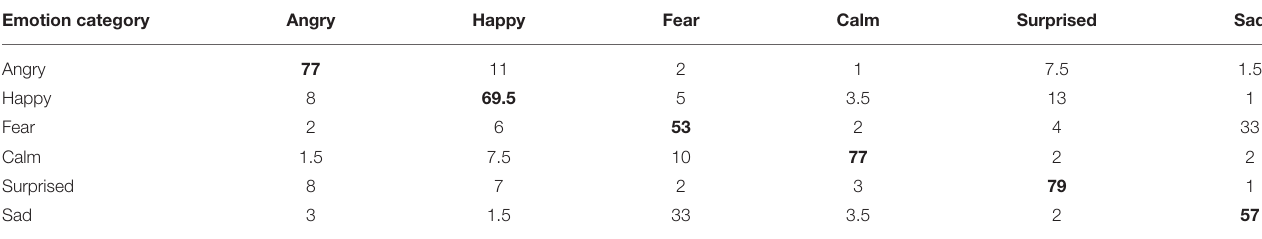
The bold values represent the recognition rate of the adopted method. TABLE 7 | Recognition rate of ILSTM in CASIA. Emotion category